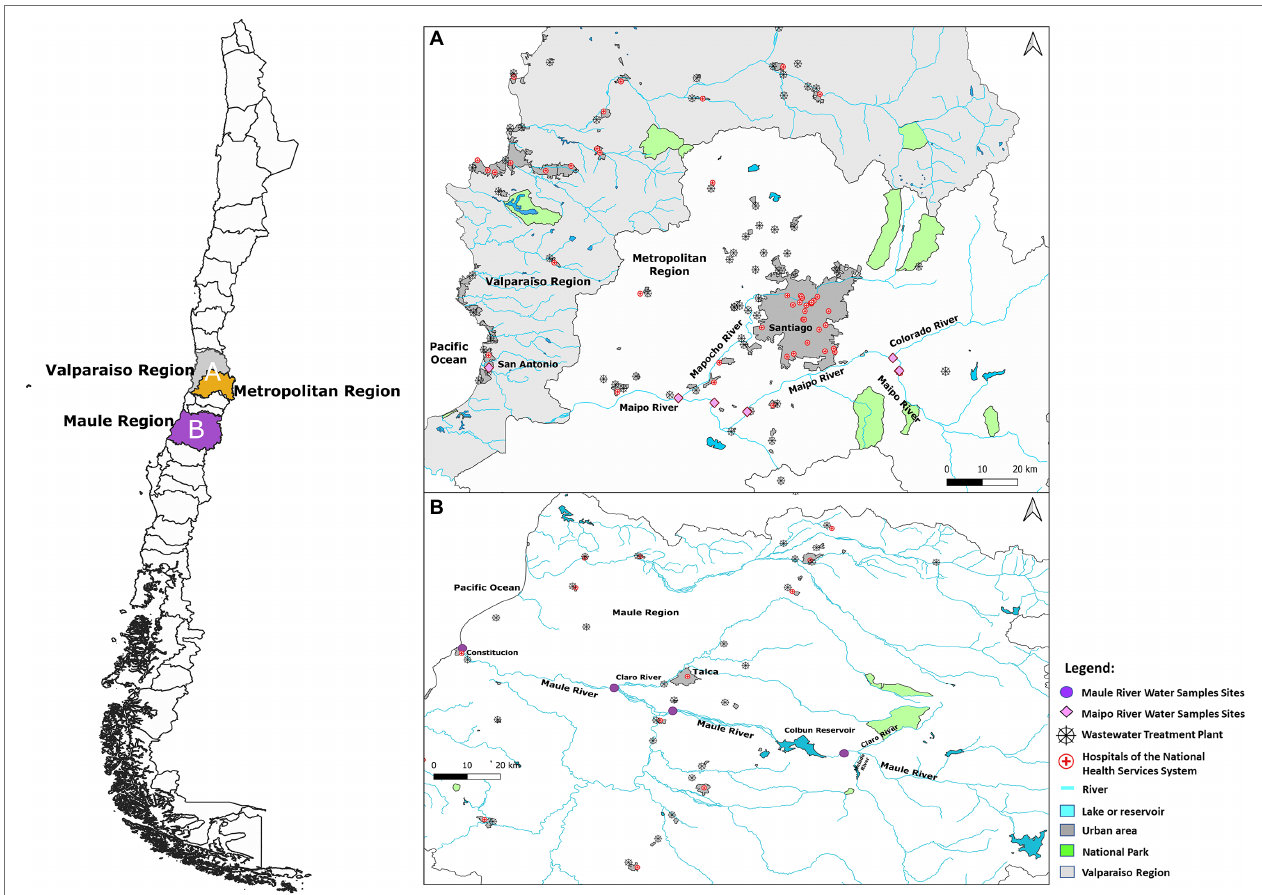
FIGURE 1 | Sampling sites located in: (A) the Maipo River system which crosses the Metropolitan and Valparaiso Regions (pink diamonds); and (B) the Maule River, which crosses the Maule region (purple circles). Map were created using Quantum GIS version (QGIS) 3.18-Zürich open-source software